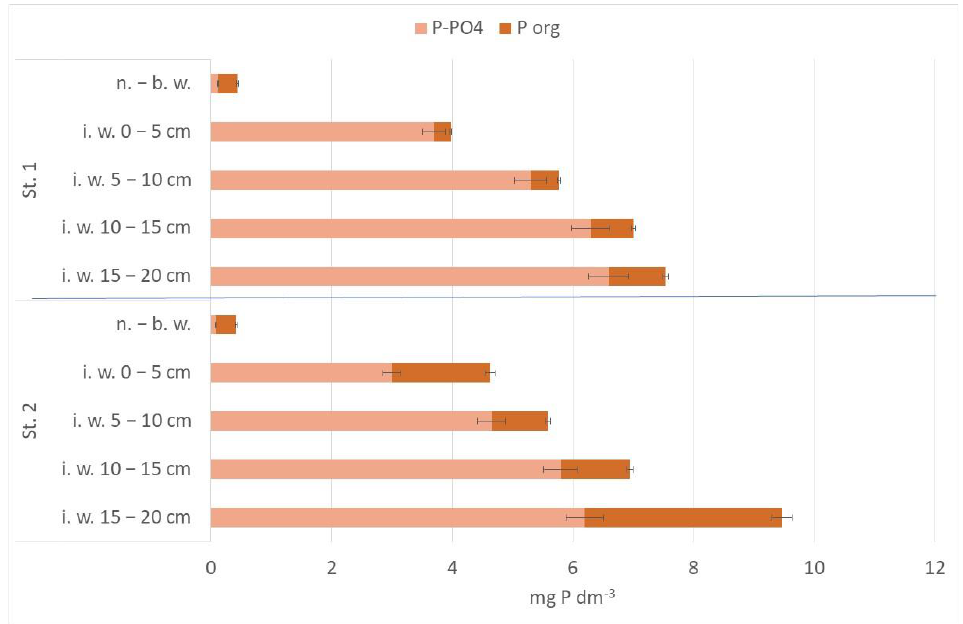
Figure 5. Amounts of P forms (±SD) in the nearbottom and pore water of Lake Kortowskie (total bar length represents the total amount of P).